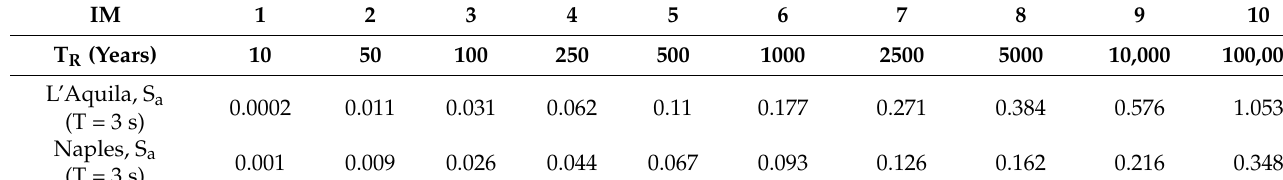
Table 2. Spectral acceleration Sa(T = 3 s) expressed in [g] for the IMs.